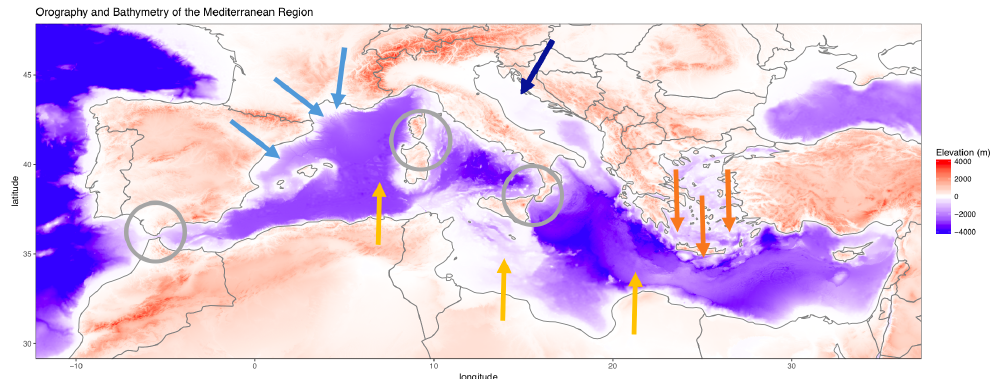
Figure 1. Mediterranean orography and bathymetry [11]. Arrows indicate mesoscale wind systems: winds channeled in valleys (light blue), Bora (dark blue), Etesians/Meltemi (orange), and southern dry winds (yellow). Circles indicate the Strait of Gibraltar, Strait of Bonifacio, and Strait of Messina (from west to